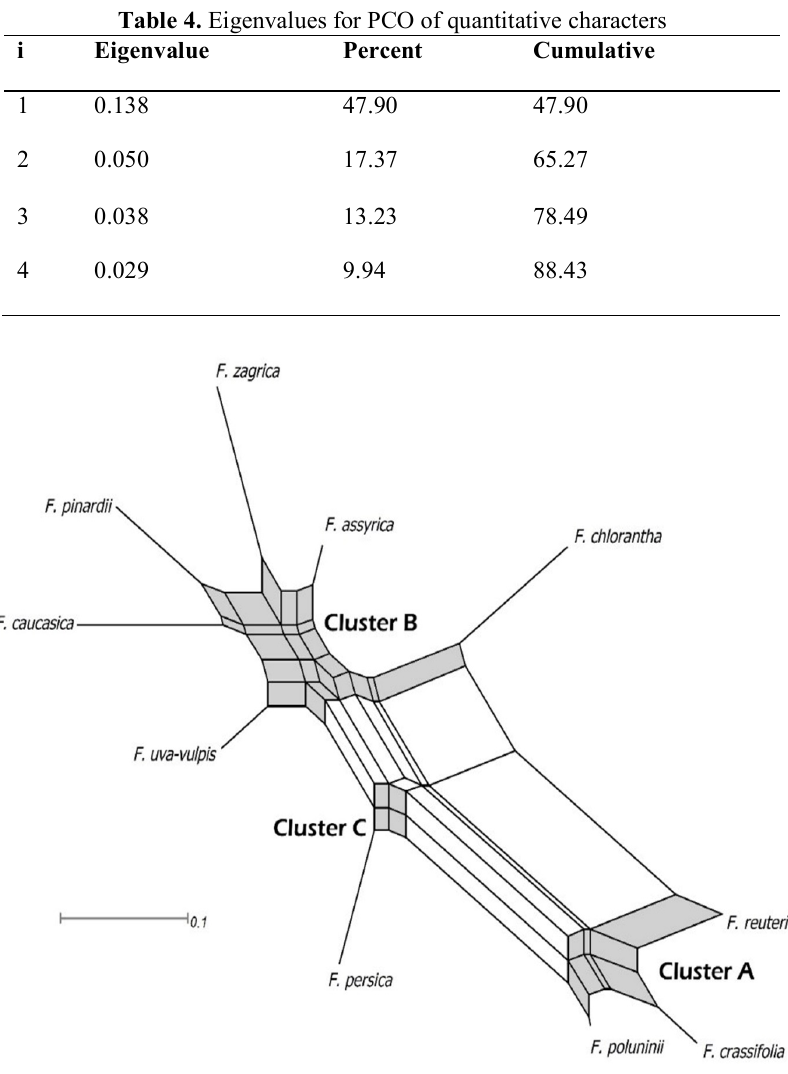
Fig. 2. Dendrogram resulted from cluster analysis of qualitative morphological characters. Three clusters are recognized corresponding to group crassifolia of sect. Trichostyleae , sect. Olostyleae , and subgen. Theresia